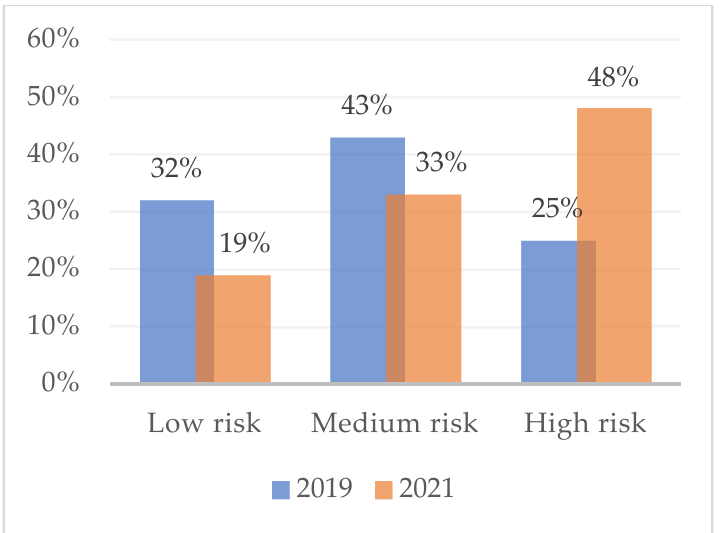
Figure 2. Risk for burnout syndrome due to personal accomplishments in February 2019 and in April 2021. n = 75.